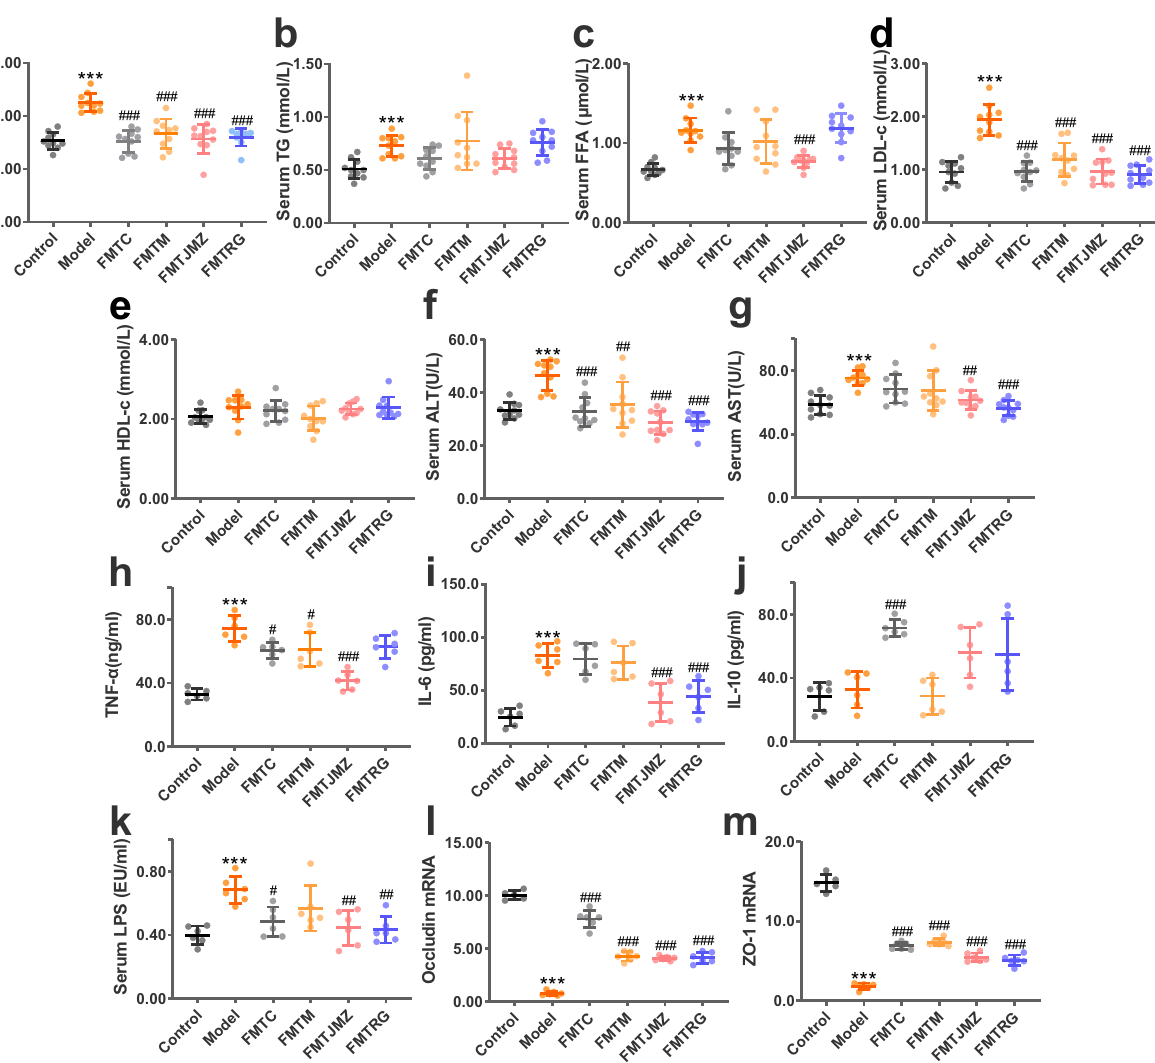
Fig. 3 CS effects on fat accumulation, liver injury and in fl ammation, and intestinal mucosal barrier injury are transferred via FMT. Serum TC ( a ), TG ( b ), FFA ( c ), LDL-c ( d ), HDL-c ( e ), Serum ALT ( f ), and serum AST ( g ), n = 10 mice/group. TNF- α ( h ), IL-6 ( i ), IL-10 ( j ), and serum LPS levels ( k ), relative expression of occludin ( l ), ZO-1 ( m ) mRNA levels, n = 6 mice/group. Data are presented as the mean ± SD. Statistical analyses were performed using Tukey ’ s multiple comparison test. * P < 0.05, ** P < 0.01, ** *P < 0.001 vs. control; # P < 0.05, ## P < 0.01, ### P < 0.001 vs.